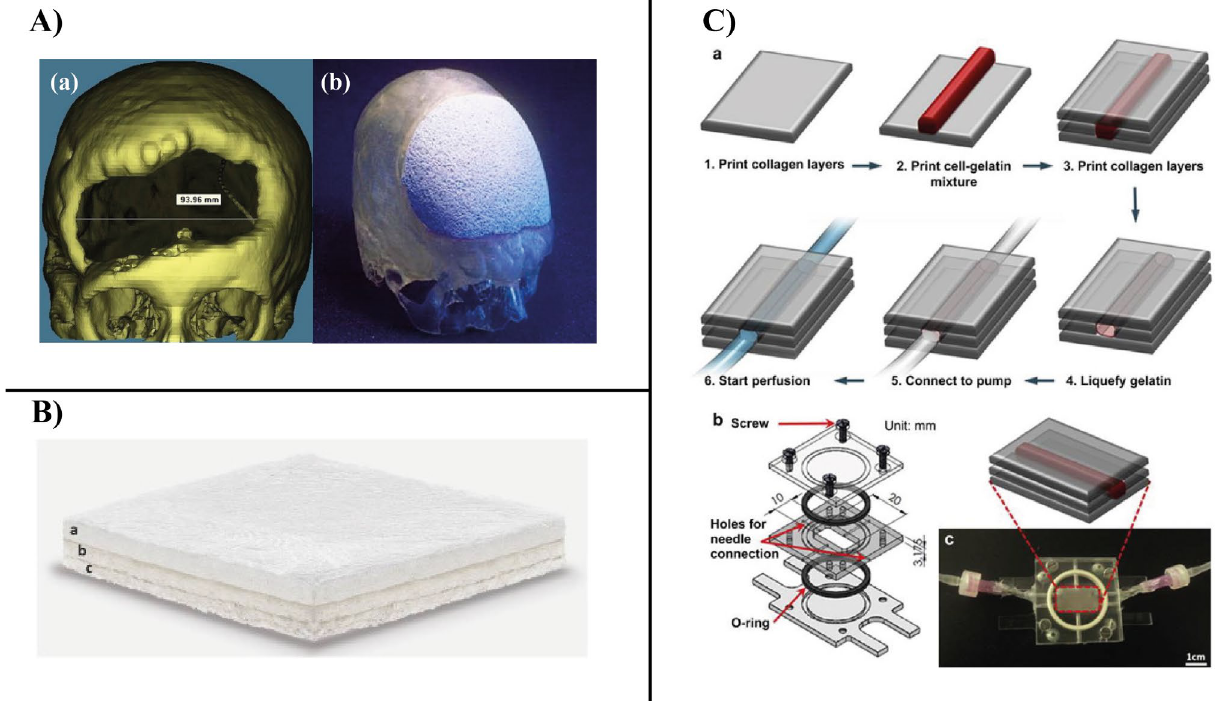
Figure 19. ( A ): (a) A 3D CT scan of a bone cranial defect. The first step to a customized graft is to acquire a patient-specific CT scan image of the defect. (b) Anatomically shaped HA scaffold that perfectly fits the defect in a skull model. A prototype acrylic resin model was fabricated by 1:1 stereolithography, replicating the skull with the defect. A custom HAp prosthesis was then fabricated and accurately refined based on the defect that the resin model exhibited [247]. ( B ): Multilayered composite scaffold with three gradients that replicates the entire articular osteochondral compartment and can initiate osteochondral regeneration. The nanostructured, biomimetic, porous, three-layer gradient composite scaffold mimics (a) the cartilage layer (type I collagen), (b) the tidemark (a combination of type I collagen and non-stoichiometric, magnesium-enriched HA), and (c) the subchondral bone (a mineralized blend of type I collagen and magnesium HA) [248]. ( C ): Method for the preparation of vascular channels using a cell-gelatin mixture. (a) Schematic description of the process. (b) Custom-made flow chamber consisting of three transparent polycarbonate parts and two O-shaped rings for sealing. (c) Image of the flow chamber connected to the perfusion system via side-mounted needles [249].